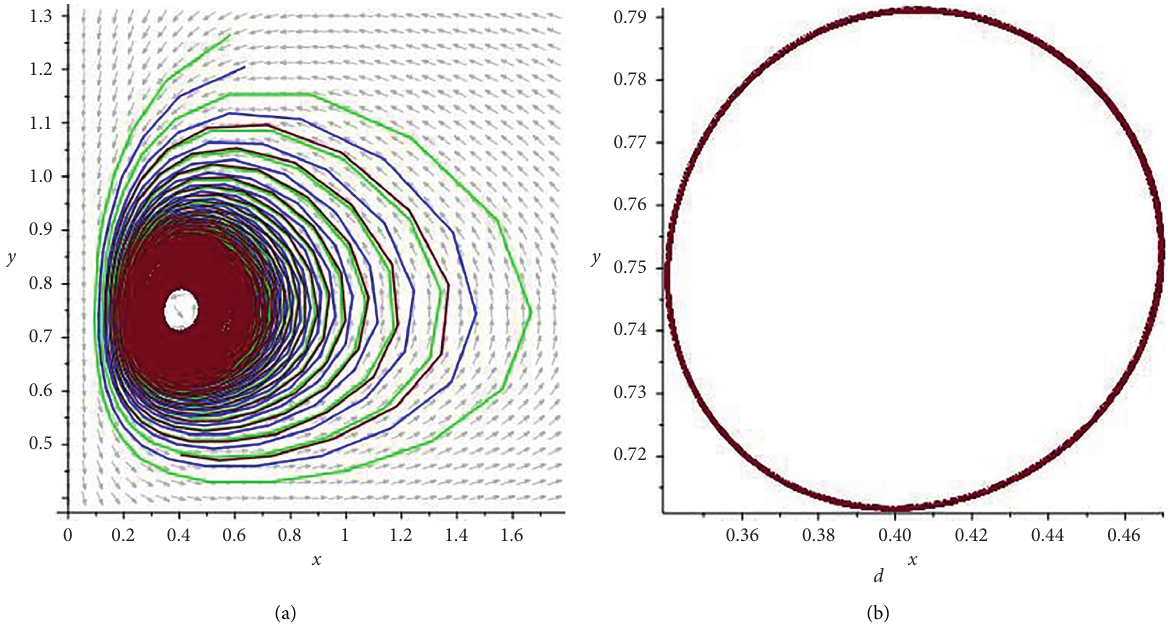
Figure 3: Figures in Example 1 with d � 0 . 053. (a) Phase diagrams around an unstable focus. (b) Enlarged phase diagrams: limit cycle.